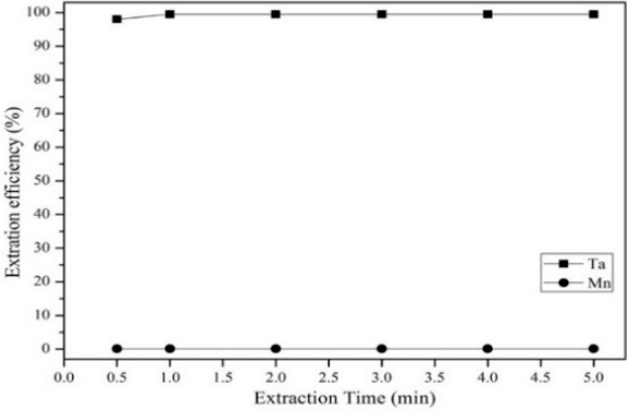
Figure 12. Effect of extraction time on extraction efficiency. pH 1. A/O = 2. Concentration: 0.025 M.